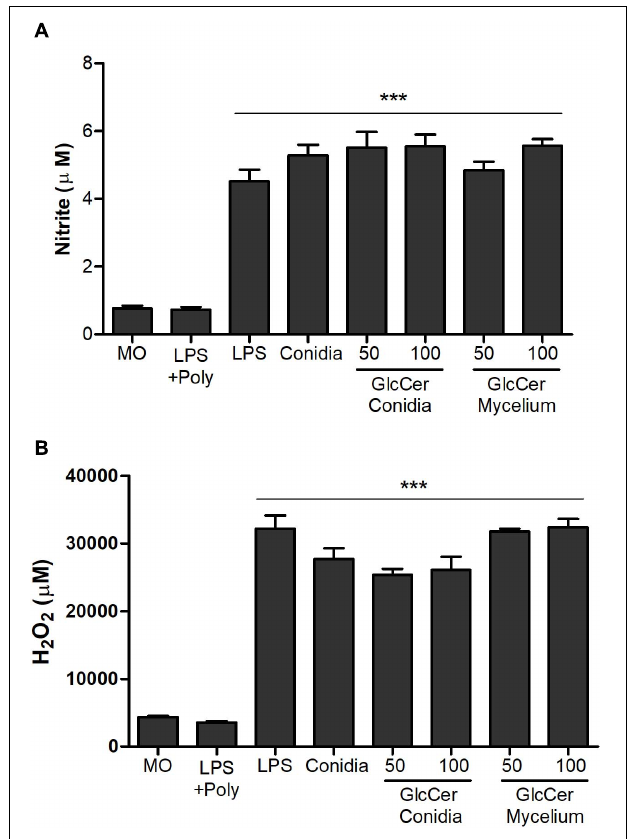
FIGURE 5 | Activation of oxidative burst from peritoneal macrophages. 2.5 × 10 5 macrophages were incubated in the presence of 50 and 100 µ g/ml at 37 ◦ C, for 2 and 24 h for quantification of NO (A) and H 2 O 2 (B) , respectively. As positive controls, LPS (10 ng/well) or L. prolificans conidia (5:1) were used. Data are the mean ± SEM of duplicate samples from four independent experiments. ∗∗∗ p < 0.0001; +Poly, polymyxin